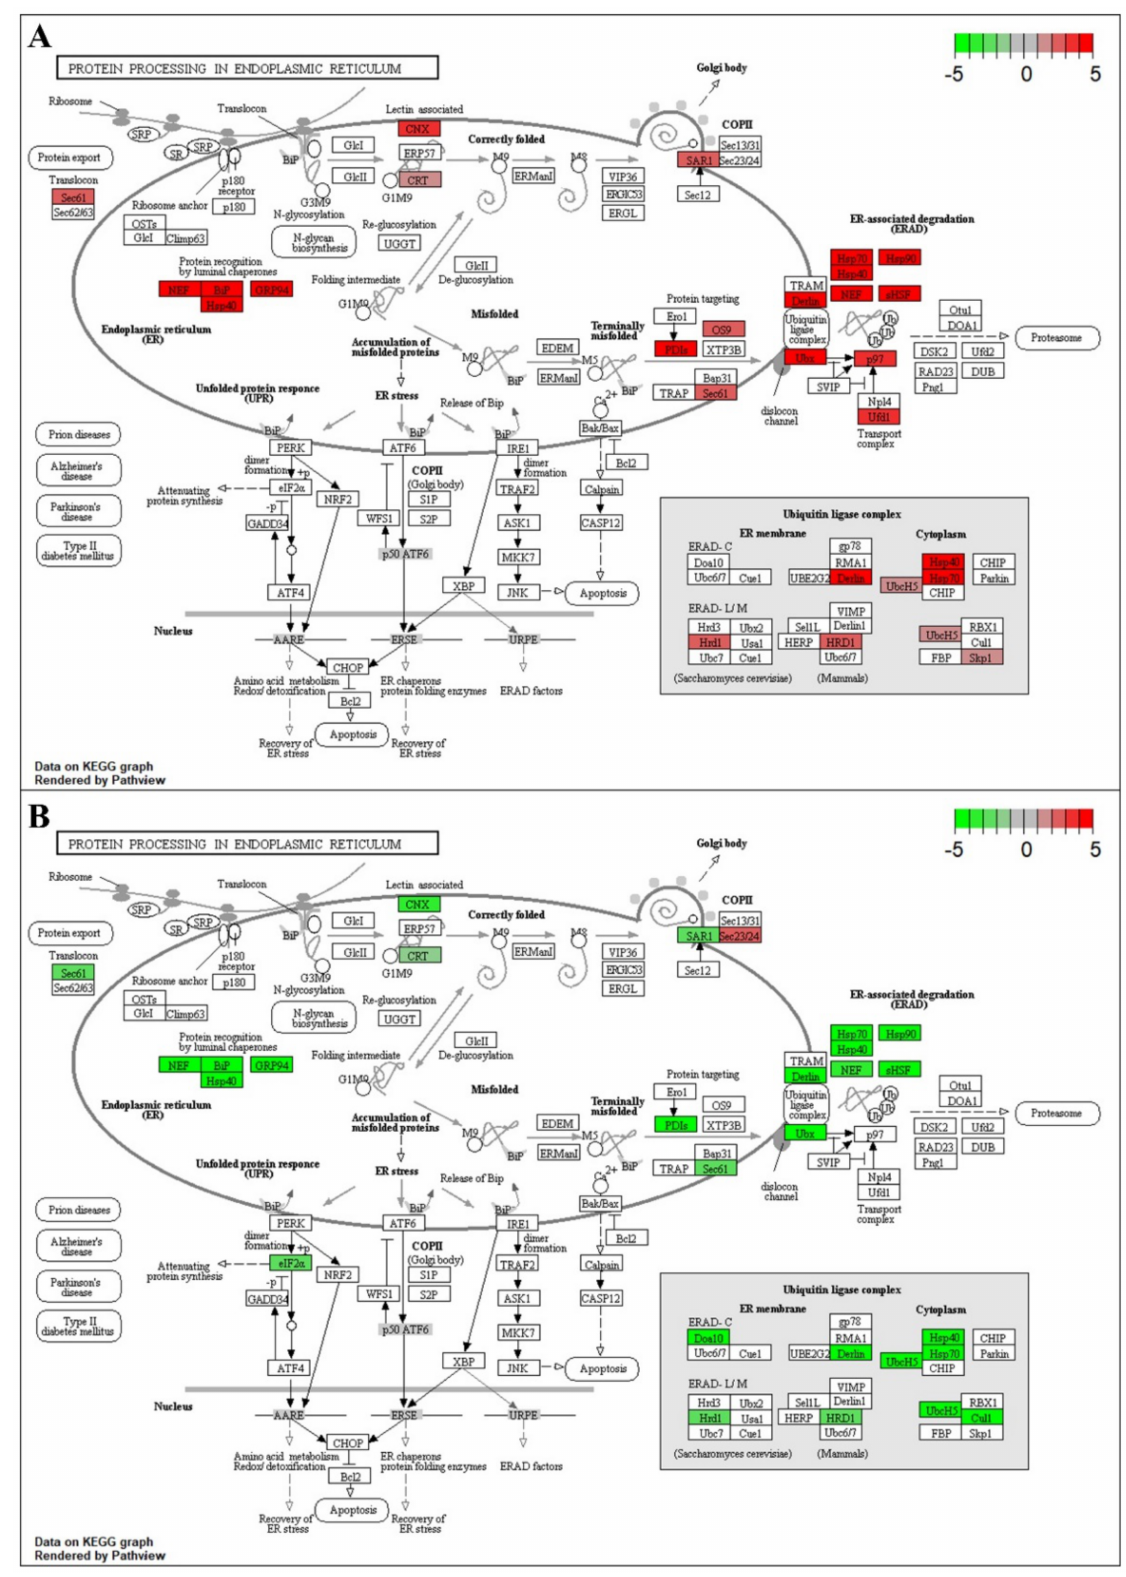
Figure 4. Protein processing in endoplasmic reticulum pathway: ( A ) Map of alignment of V. darrowii DEGs to V. vinifera genome at 6-h heat stress. (B) Map of alignment of V. darrowii DEGs to V. vinifera genome at 9-h heat stress. The colored box represents DEGs, and their degree of expression is depicted by color variations, with red the most upregulated ( p < 0.05) and green the most downregulated ( p < 0.05), white box represents no significant differences in gene